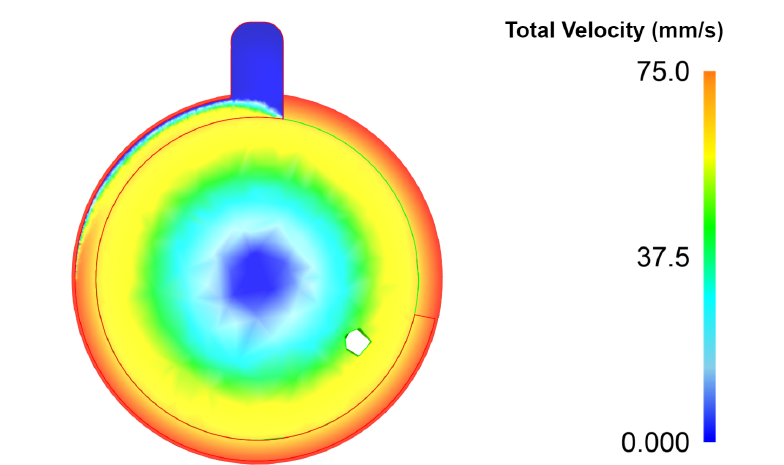
Figure 9. Section through the groove of the conform wheel displaying maximum element velocity at 50 RPM. The feedstock wire has the same velocity as the wheel in the primary grip zone. In the extrusion grip zone, the feedstock is stationary as it sticks to the wall of the housing, whereas at the inner wall of the groove the material has the velocity of the wheel.